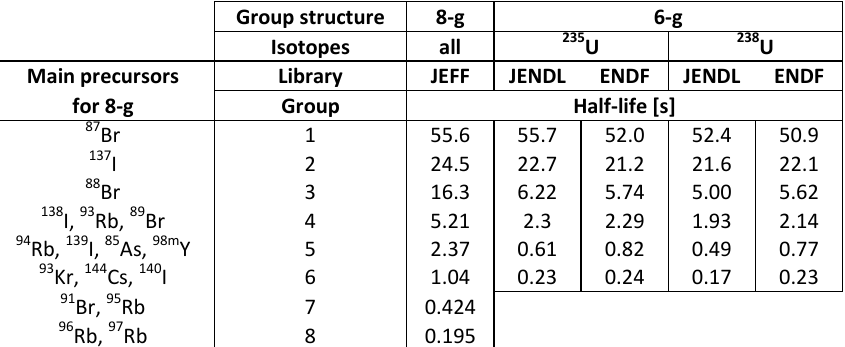
Table 1. Half-lives of precursor groups in JEFF-3.1.2, JENDL-4.0, ENDF/B-VII.1. Group structure 8-g 6-g Isotopes